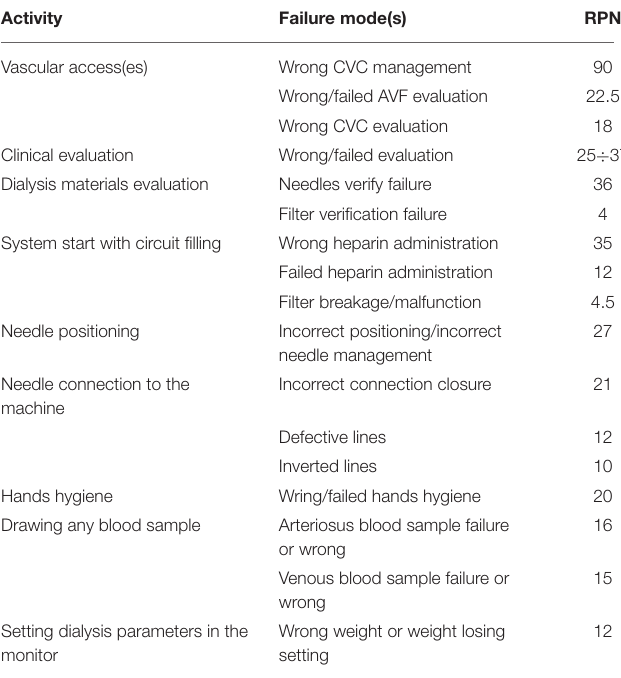
TABLE 4 | Proposed master list as resulted from the failure modes of the FMEA application to the HD